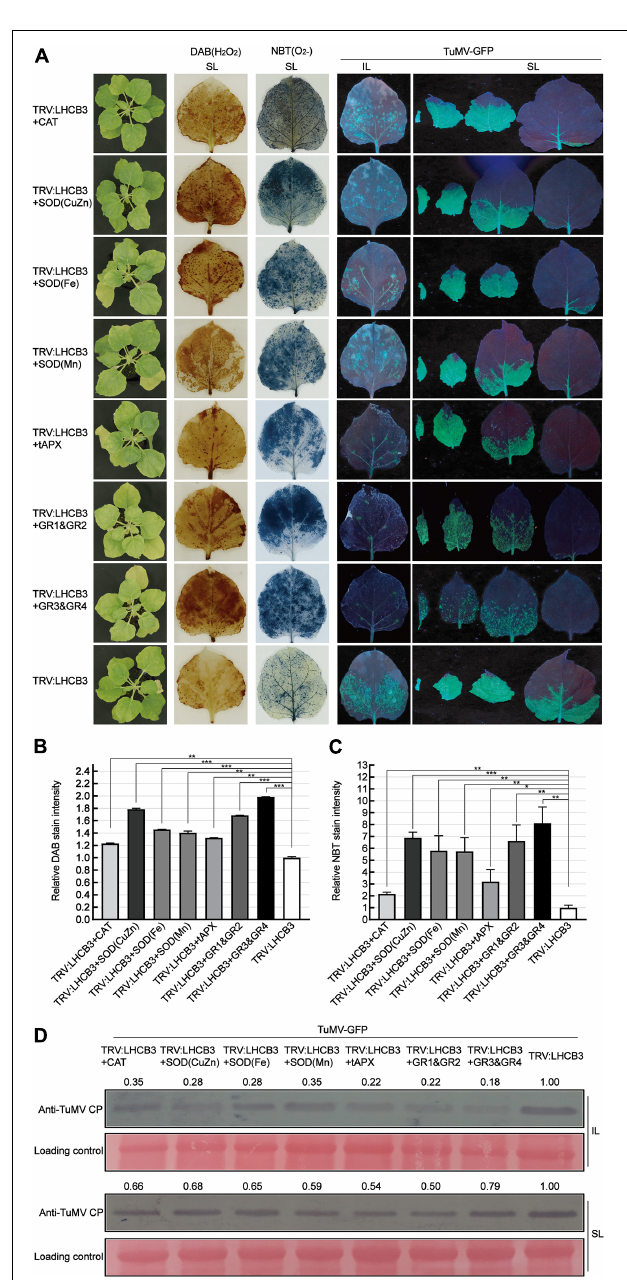
FIGURE 5 | Co-silencing of NbLHCB3 and genes in the ROS scavenging pathway further suppressed TuMV-GFP infection. (A) The phenotype of plants under bright light is shown at the left. DAB and NBT staining show ROS accumulation in the silenced plants. TuMV-GFP infection in the inoculated leaves (IL) and systemically infected leaves (SL) was monitored under UV light at 8 dpi. SL at the corresponding location in plants were collected for analysis. (B) The relative DAB stain intensity calculated by IMAGE J software. (C) The relative NBT stain intensity calculated by IMAGE J software. (D) Western blotting showed the accumulation of TuMV-GFP CP in the plants at 8 dpi. The relative intensity of the blot signal quantified by IMAGE J software is shown on the lanes. Bars represent the standard errors of the means from three biological repeats. A two-sample unequal variance directional Student’s t -test was used to test the significance of the differences (* P < 0.05; ** P < 0.01; *** P <